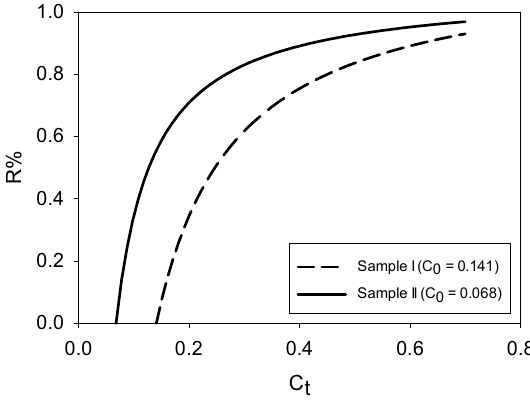
Figure 2. Required percentage water removal to concentrate stick water to target mass fraction solids, C t .